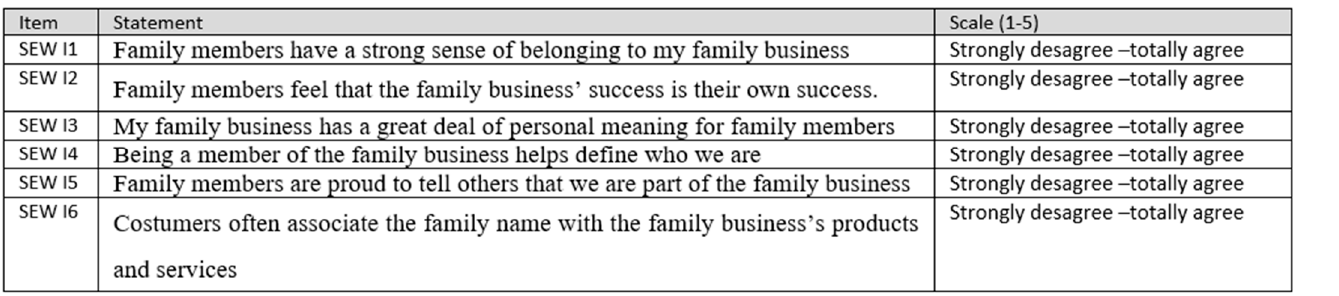
Figure 3. Statements and scales used for the measurable items that represent SEW dimension I. Source: